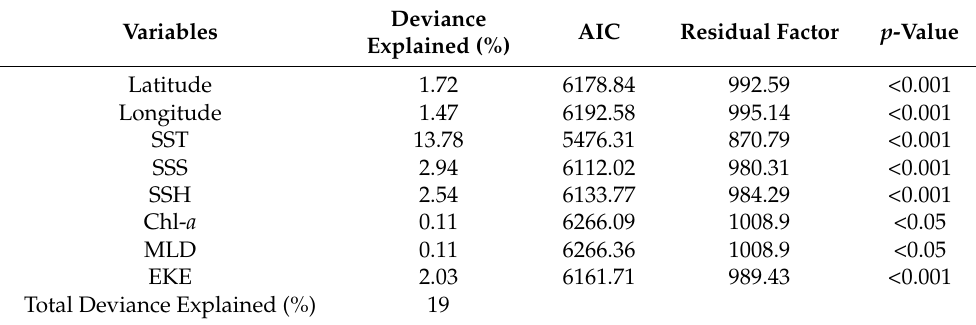
Table 2. Summary statistics for the building of the GLMs of each variable added and determined using the residual factor. Deviance explained (DE) by the model represented the goodness-of-fit of the model; approximate Akaike information criterion (AIC) was employed to identify the optimal model; are examined to find significant predictors.